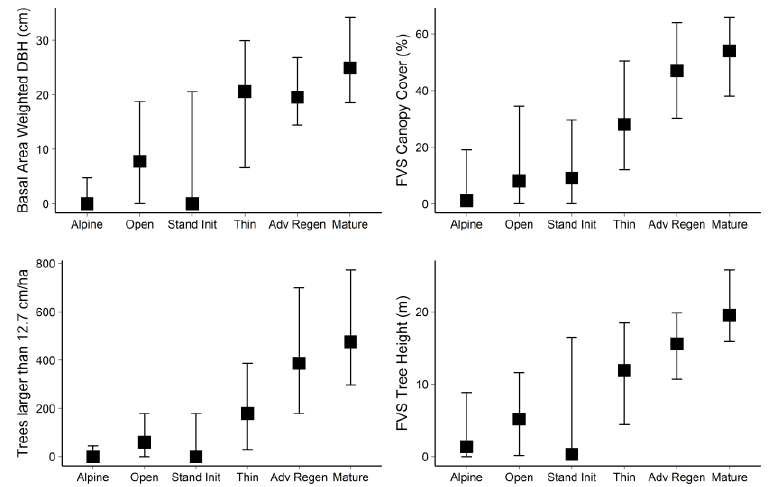
Figure 5. Median values of forest structural metrics from USDA Forest Inventory and Analysis program (FIA) across our six time-series-informed structural classes for the year 2013. Whiskers indicate the first and third quartile (i.e., the interquartile range). Values derived using the Forest Vegetation Simulator (FVS [39]) are indicated. We observed that tree density, tree size, and tree height follow a general pattern of increasing from non-forest to forested classes, i.e., all values for Thin, Advanced Regeneration, and Mature were higher than those for Alpine, Open, and Stand Initiation.